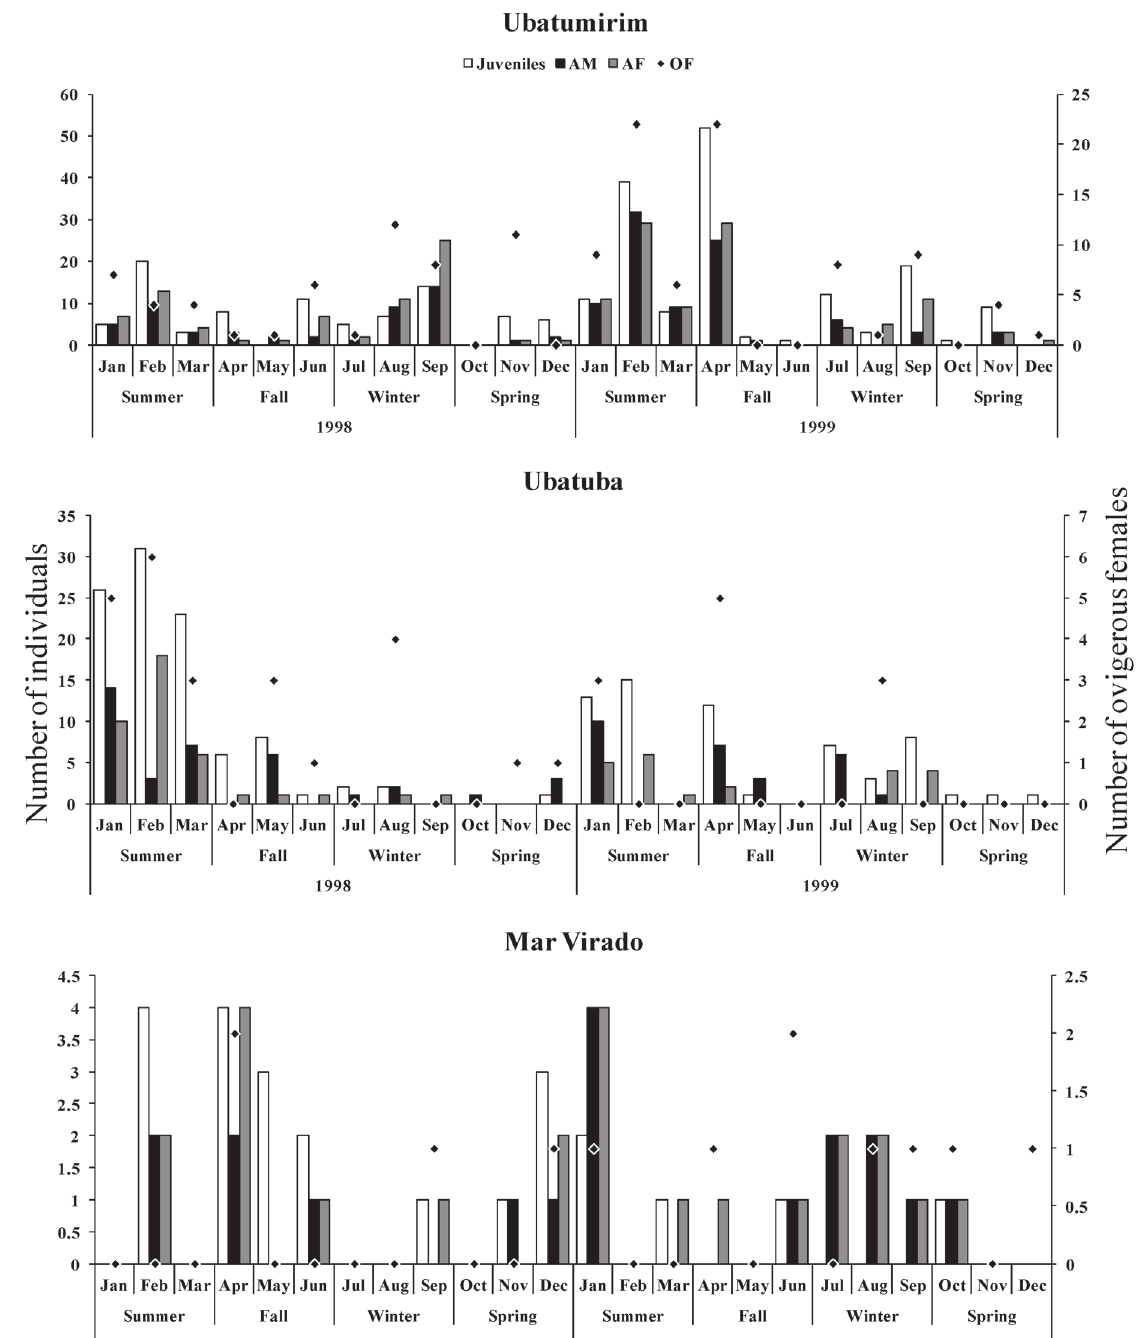
Figure 6. Hexapanopeus paulensis . Temporal distribution of individuals in Ubatumirim, Ubatuba and Mar Virado bays, from January 1998 to December 1999. AM = adult males, AF = adult females and OF = ovigerous